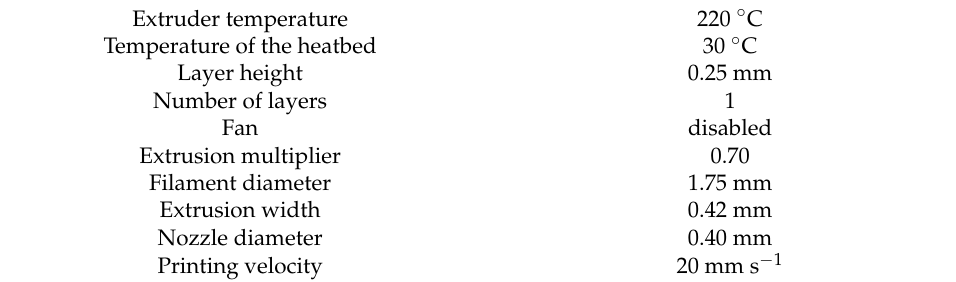
Table 1. Printing parameters for the Varioshore TPU